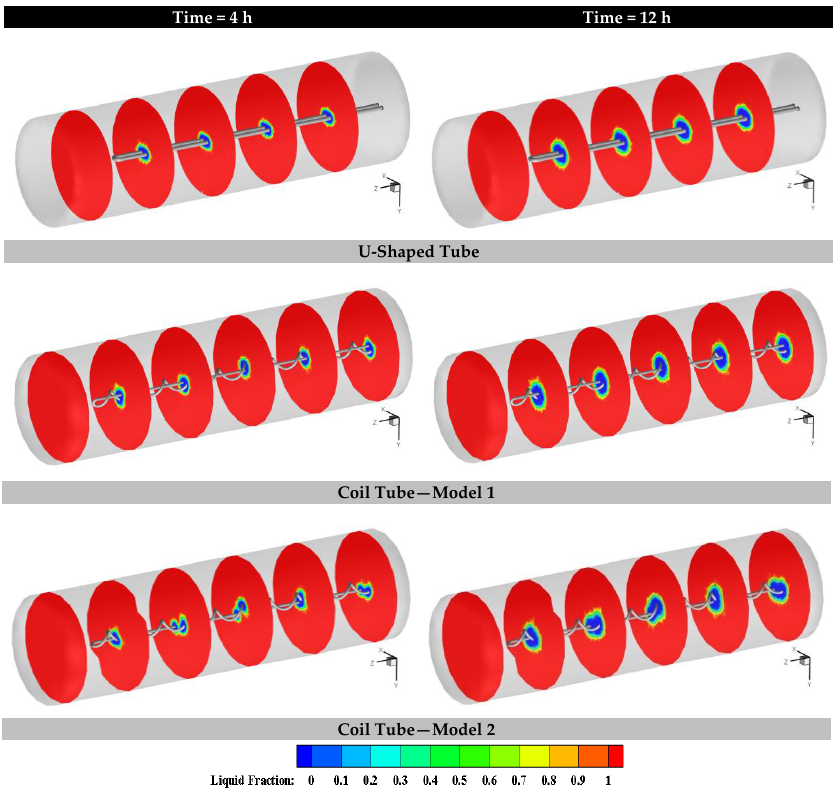
Figure 8. Contours of the liquid fraction (LF) at five various sections of the shell for the three types of tubes and the system in the horizontal position.